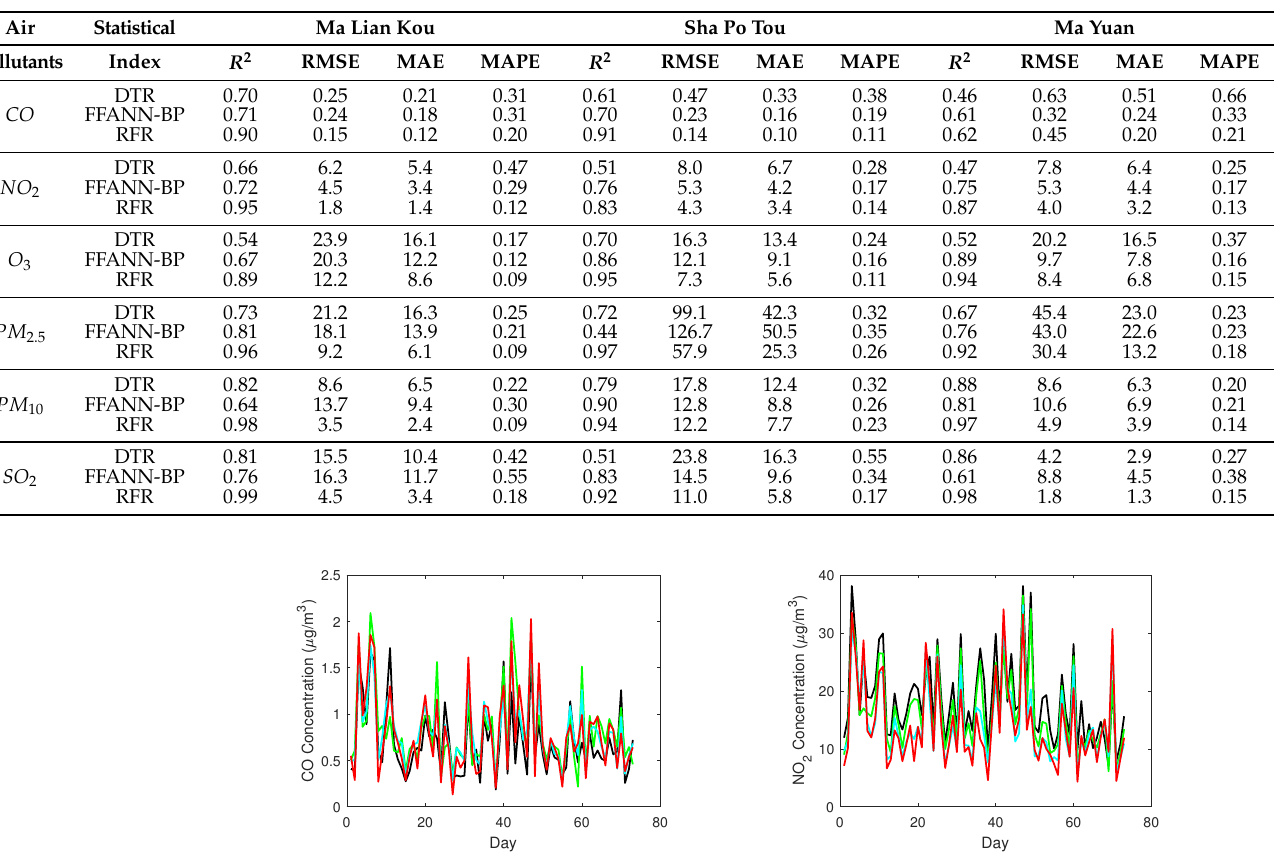
Figure 7. The observed concentrations and the predicted concentrations of DTR, FFANN-BP and RFR for CO and NO 2 at Ma Lian Kou, where the red line and the black, green and lightcyan lines represent the observations, and the predictions of DTR, FFANN-BP and RFR,